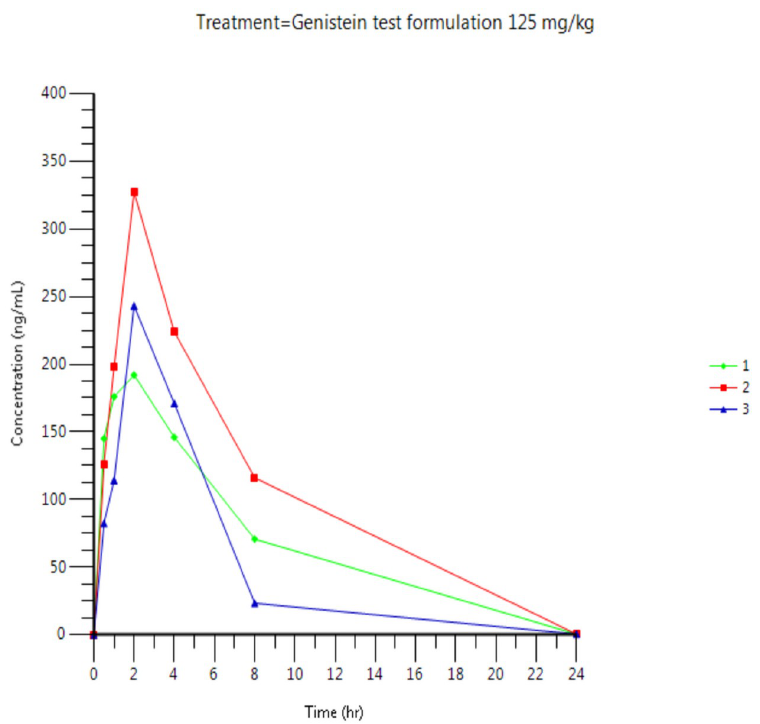
Fig 3. Individual plasma concentration of genistein after oral administration of genistein (125 mg/kg) as test formulation in male Wistar rats.